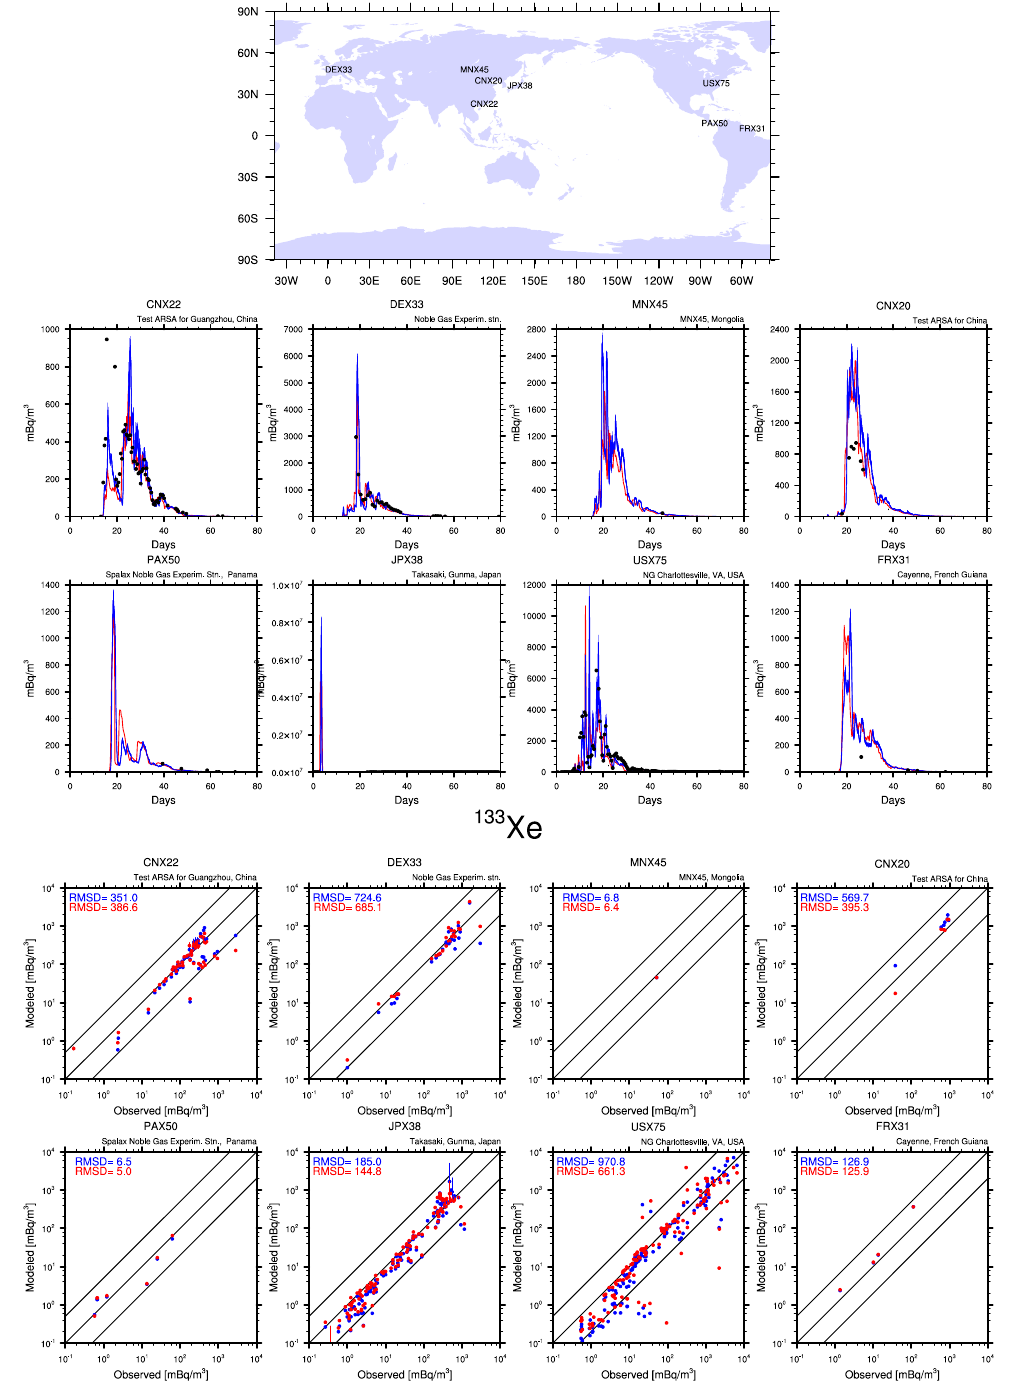
Fig. 3. Top: CTBTO measurement network station location and code for the noble gas 133 Xe for the subset of stations with measurements available used in our study. Middle: Observed (black points) and modeled (solid lines) surface concentrations of 133 Xe at the eight stations. T255 horizontal resolution is shown in blue and T106 in red. The time axis represents days after the accident. Bottom: Modeled versus observed surface concentrations of 133 Xe at the eight stations. The diagonal lines represent the 1:1 ratio and the factor of 5 over- and underestimates.